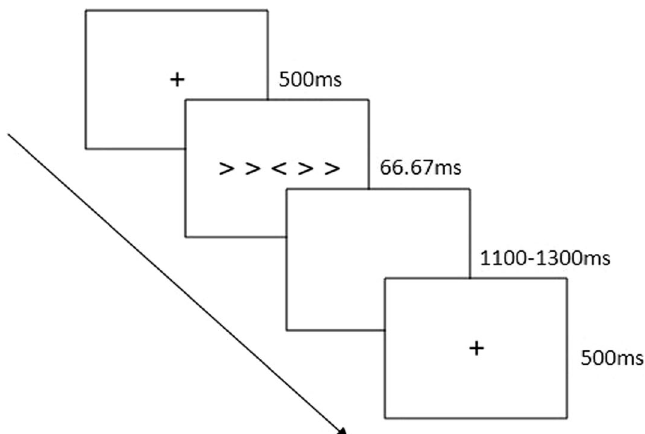
Fig. 1 Experimental stimulus presentation